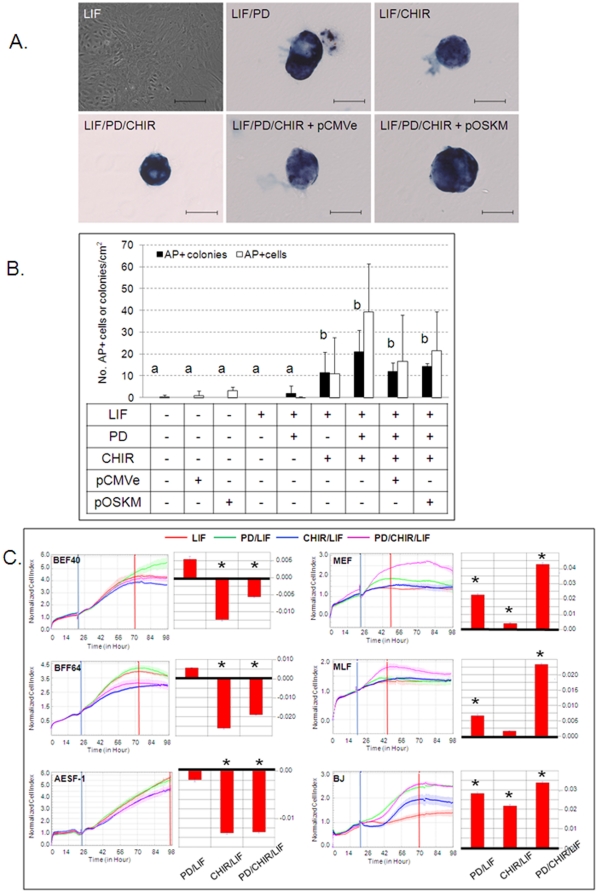
2i/LIF affects colony formation and AP induction.(A) AP+ colonies after no, empty vector (pCMVe) or pOSKM-transfection. Scale bar = 100 µm; (B) Quantification of AP+ iPSC-like colonies, 15 days after passaging BEF40; ab treatments differ P<0.005 for colonies. (C) xCELLigence™ real-time kinetic profiling. Cell indices were determined for bovine and murine embryonic (BEF40, MEF, respectively), bovine fetal (BFF) and bovine, murine and human adult fibroblasts (AESF, MLF, and BJ, respectively). Curves were normalized after compound addition (blue vertical line) and slopes (red bars) determined during log phase (between blue and red vertical lines); * =  slopes differ P<0.05 from LIF-treated control.